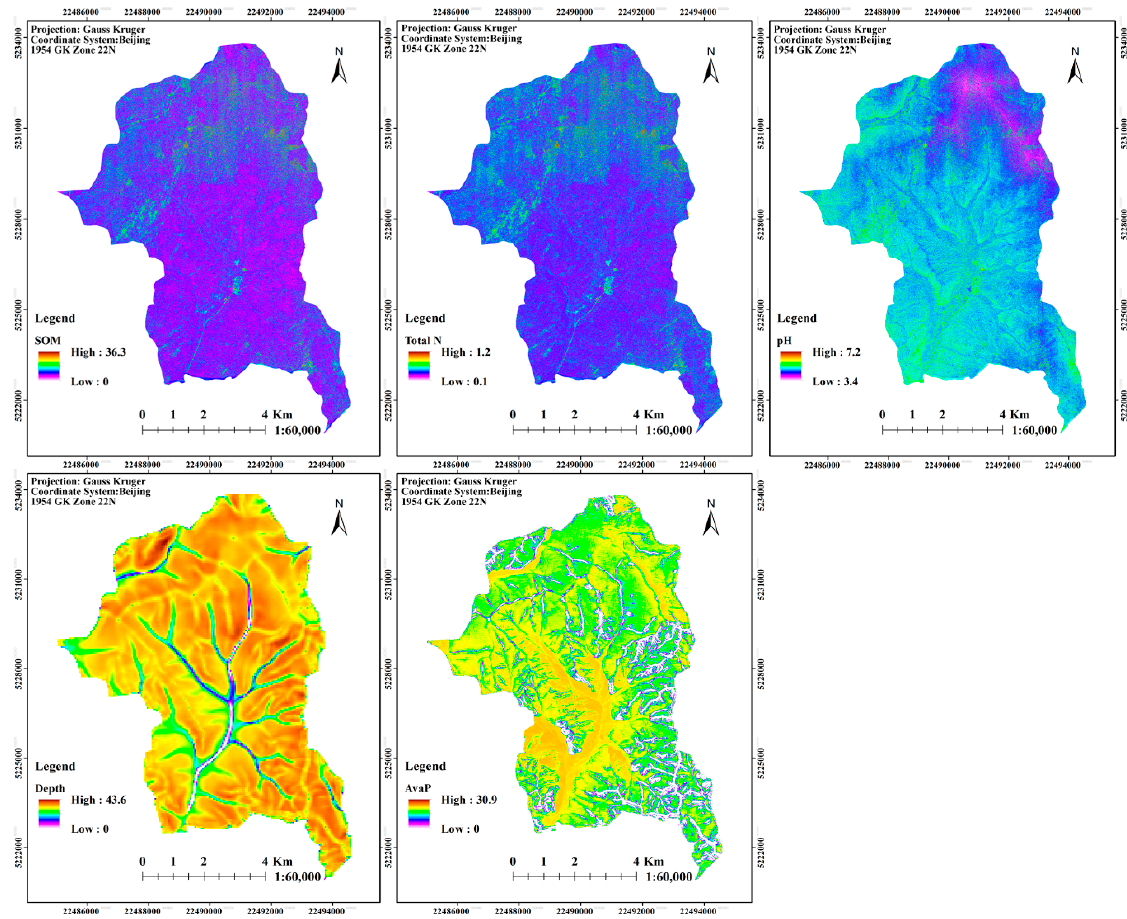
Figure 3. The soil maps established by each selected variable in the optimal scale. The soil maps for SOM, Total N, and pH have the same scale, which is 1.5 m grid resolution and 4.5 m neighbor extent; the scale of the soil map for Depth is 50 m grid resolution and 250 m neighbor extent; and the scale of the soil map for AvaP is 10 m grid resolution and 70 m neighbor extent.